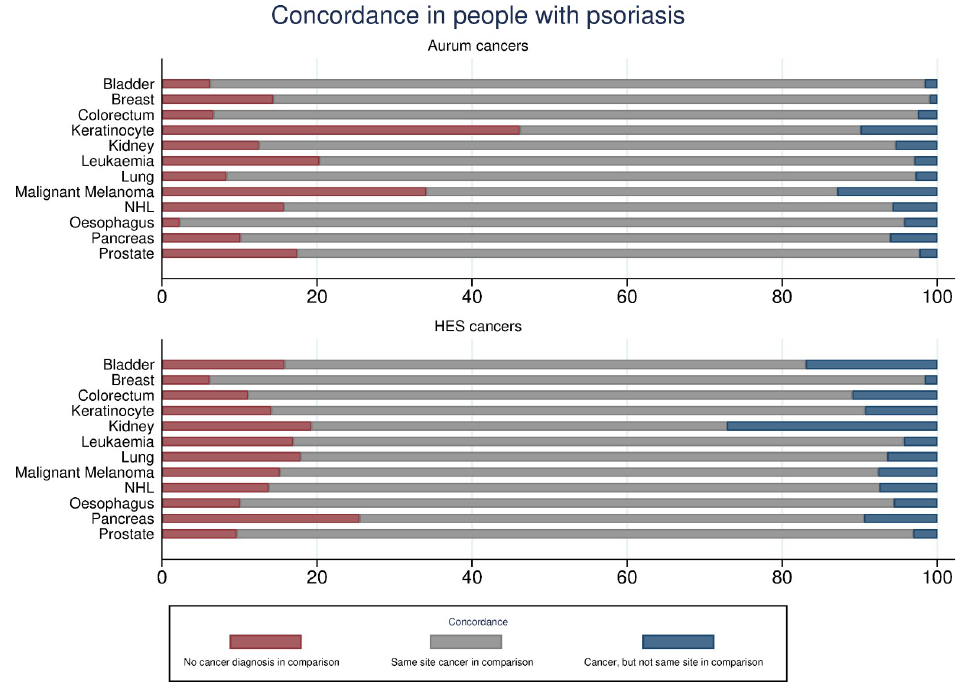
Fig 1. Concordance in cancer recording for Aurum-linked people with